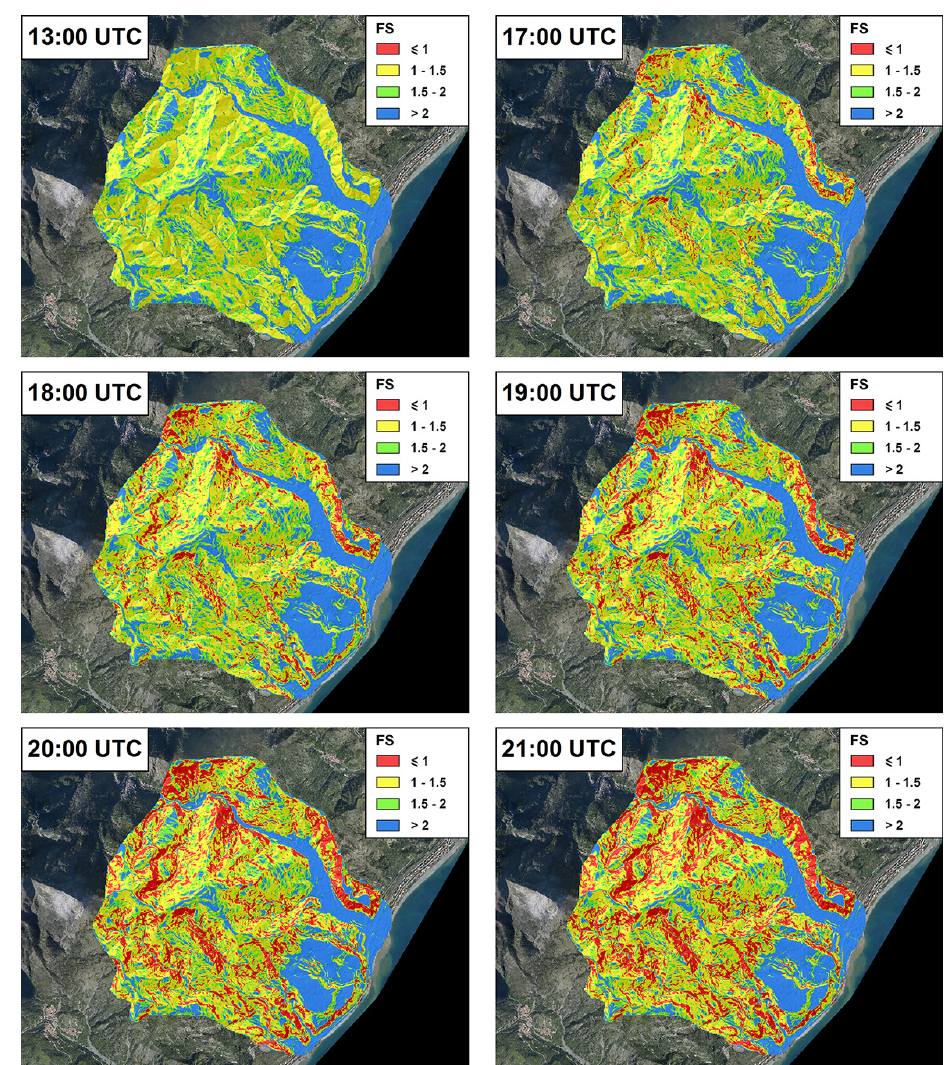
Figure 9. Slope stability conditions, expressed in terms of safety factor (SF), during the 1 October 2009 event according to the TRIGRS